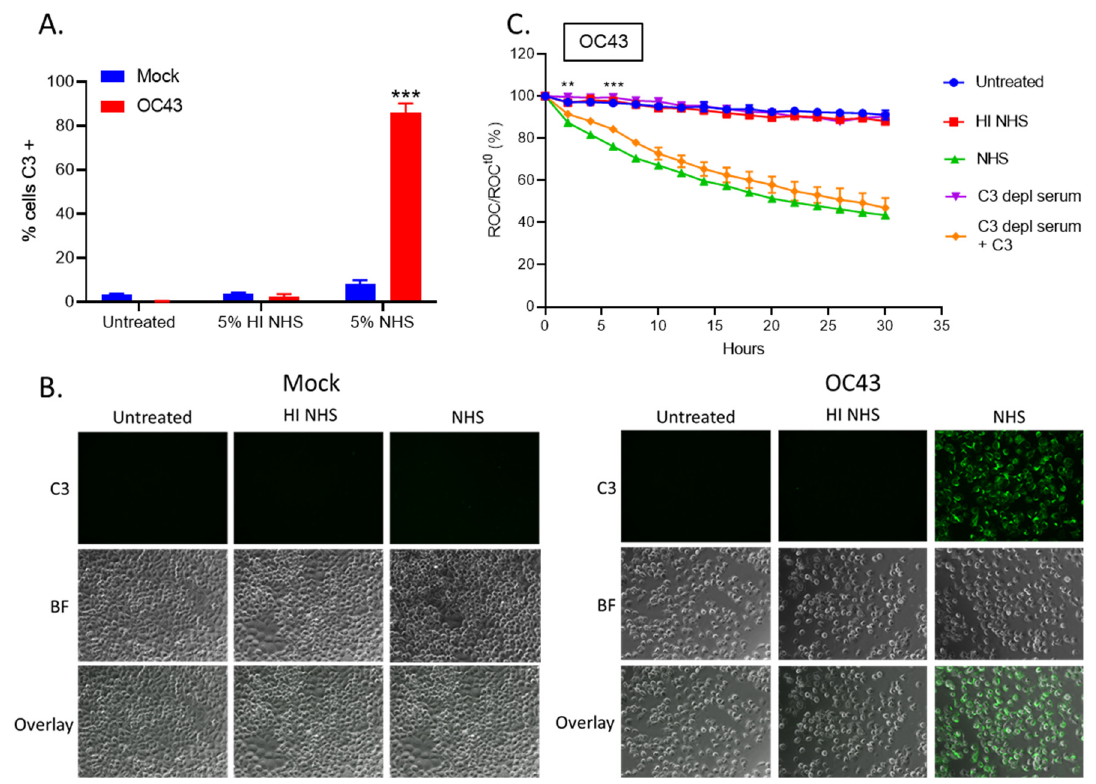
Figure 3. C3 is deposited on OC43 infected lung cells and is required for NHS-mediated cell killing. ( A , B ) Uninfected (mock) or OC43 infected H1299 cells were either untreated, HI NHS, or NHS treated for 1 h at 37 °C. After incubation, cells were washed and stained for surface C3 deposition and quantified by flow cytometry ( A ) or by immunofluorescence ( B ). ( C ) Human lung H1299-NLR cells were uninfected (mock) or OC43 infected, and then either left untreated or treated with 10% HI NHS, 10% NHS, 10% C3-depleted (depl) serum, or 10% C3-depl serum supplemented with physiological levels of C3. Red fluorescence was acquired at intervals of every 2 h over 30 h by real-time imaging using the IncuCyte instrument. ROC per well was calculated and normalized to the value at time zero (ROC t0 ) when treatments were added and expressed as percent of time zero. Values in all panels are the mean of three replicates and error bars representing standard deviation, with ** indicating p -value of <0.01 and *** indicating p -value of <0.001 comparing NHS treated versus HI NHS treated infected samples ( A ) or NHS versus C3 depl serum treated infected samples ( C ). Mock denotes uninfected control